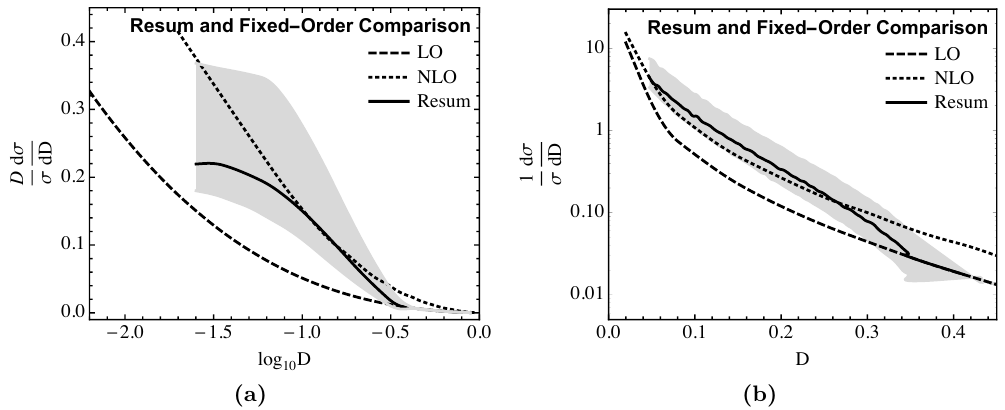
Figure 5. Comparison of our resummed prediction to leading and next-to-leading (cid:12)xed order distributions on a logarithmic scale (left) and a linear scale (right). The gray band represents an estimate of scale uncertainties in the resummed prediction. The termination of the resummed prediction just below D 10 (cid:0) 1 : 5 is due to the QCD Landau ’